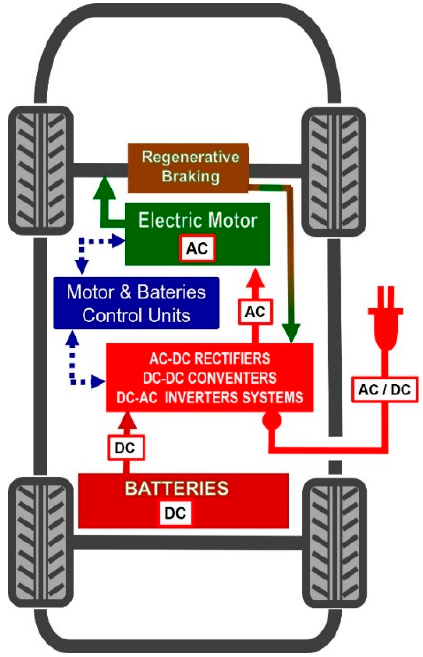
Figure 3. Battery Electric Vehicle (BEV) type electric car drive system.